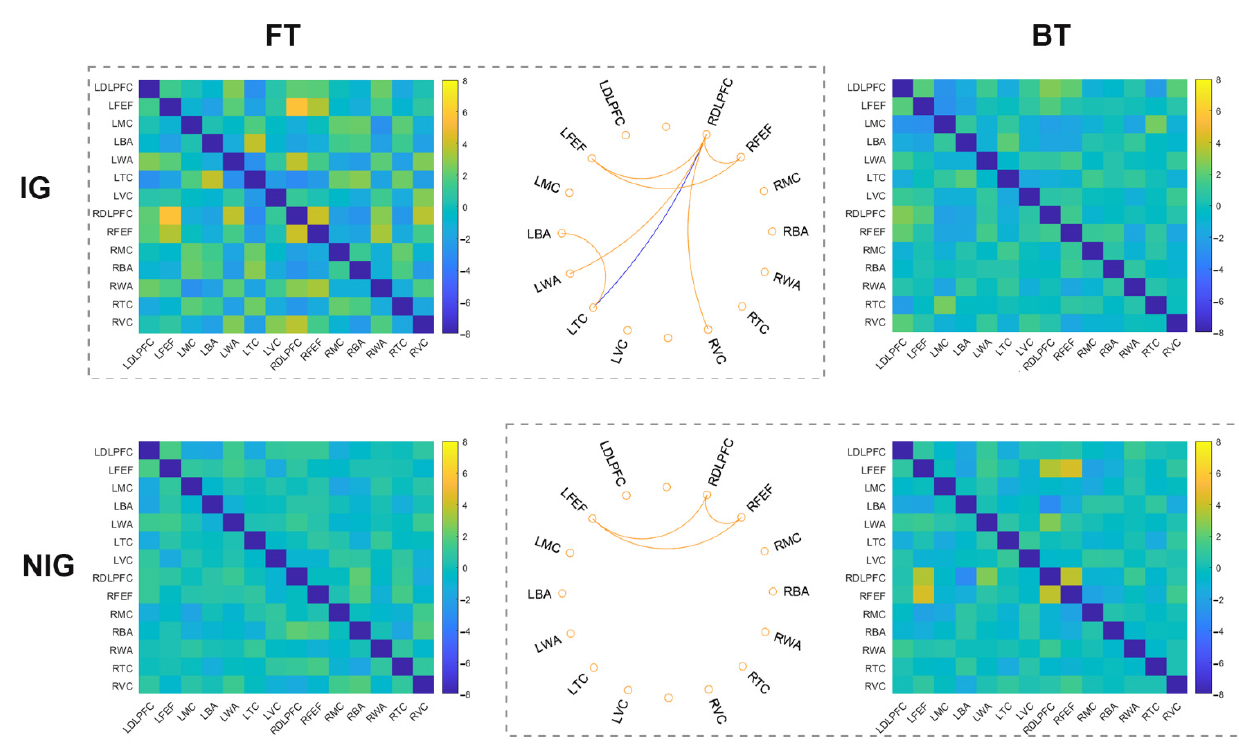
Figure 3. The results for each translation task for the IG and NIG. Circle plots showed significant connections after FDR correction (yellow: increased FC; blue: decreased FC). Heat maps displayed t values of each connection among the AOIs (DLPFC: dorsolateral prefrontal cortex; FEF: frontal eye fields; MC: motor cortex; BA: Broca’s area; WA: Wernicke’s area; TC: temporal cortex; VC: visual cortex; L: left; R: right).